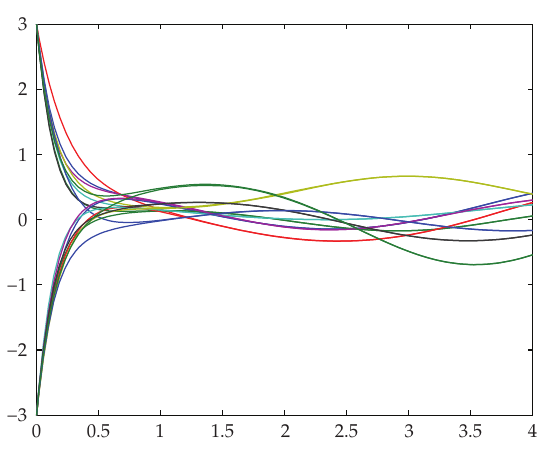
Figure 1: States of networks (cid:4) 5.1 (cid:5) with t ∈ (cid:8) 0 , 4 (cid:9)